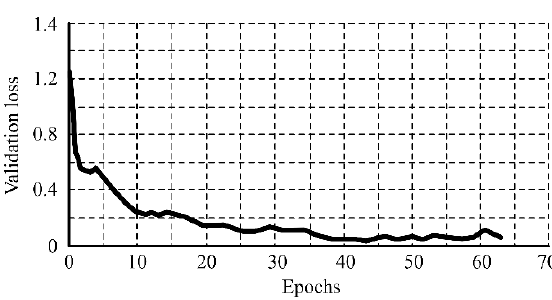
Figure 9. CNN validation loss for every training epoch. Table 1. Confusion matrix for test dataset.